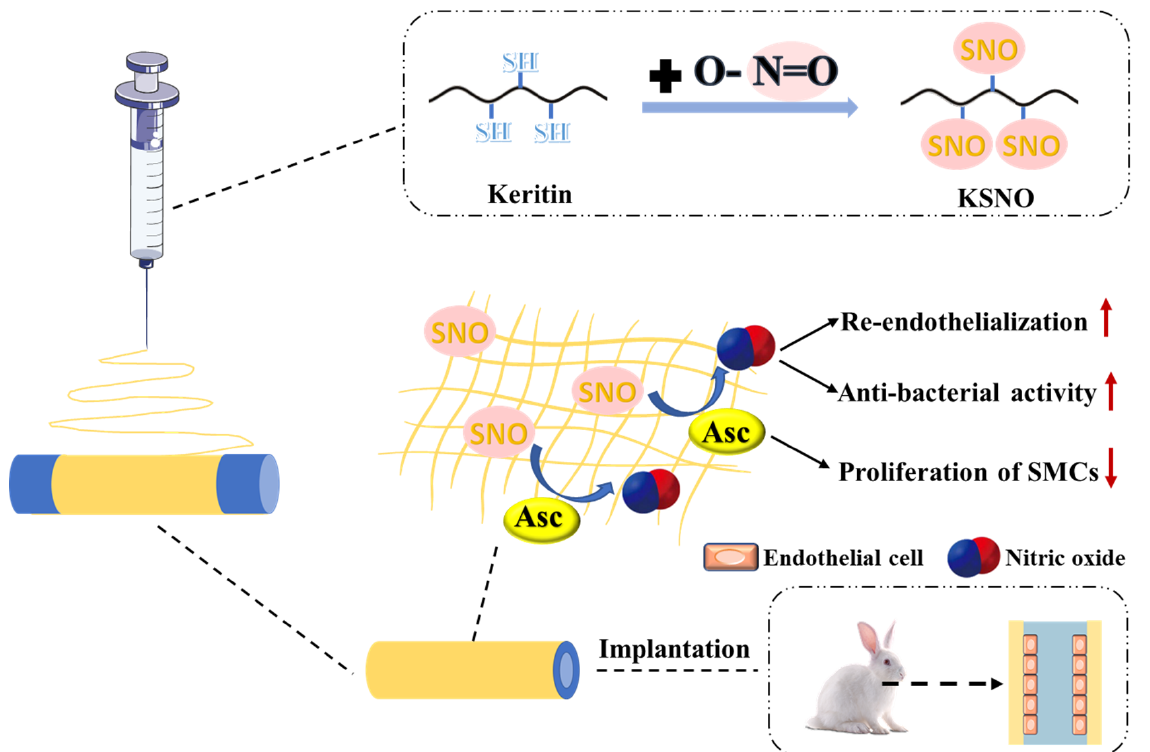
Figure 6. Schematic illustration of KSNO. PCL/KSNO vascular graft was prepared by co-electrospinning KSNO and PCL. NO generation, cytotoxicity, and blood compatibility, as well as the regulation of vascular cells by NO, were examined. PCL/KSNO graft was implanted and investigated in a rabbit carotid artery replacement model to evaluate the endothelialization and revascularization. Upward arrows in red represent enhancement, and downward arrows in red represent inhibition. Reproduced with permission from [101], International Journal of Biological Macromolecules, 2021.